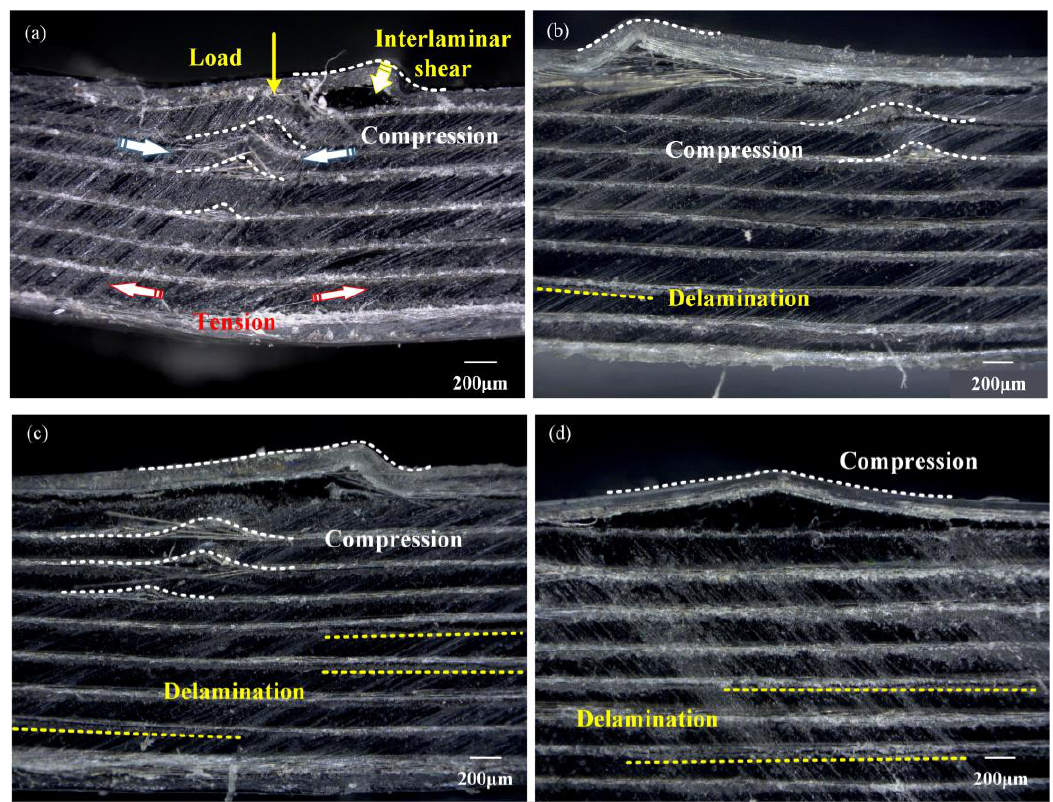
Figure 6. The partial enlarged images of multi-CFPLs in cross section with different layers of unit-CFPLs: ( a ) 7 layers; ( b ) 8 layers; ( c ) 9 layers; ( d ) 10 layers. All these images were taken at major failure locations after the flexural tests.